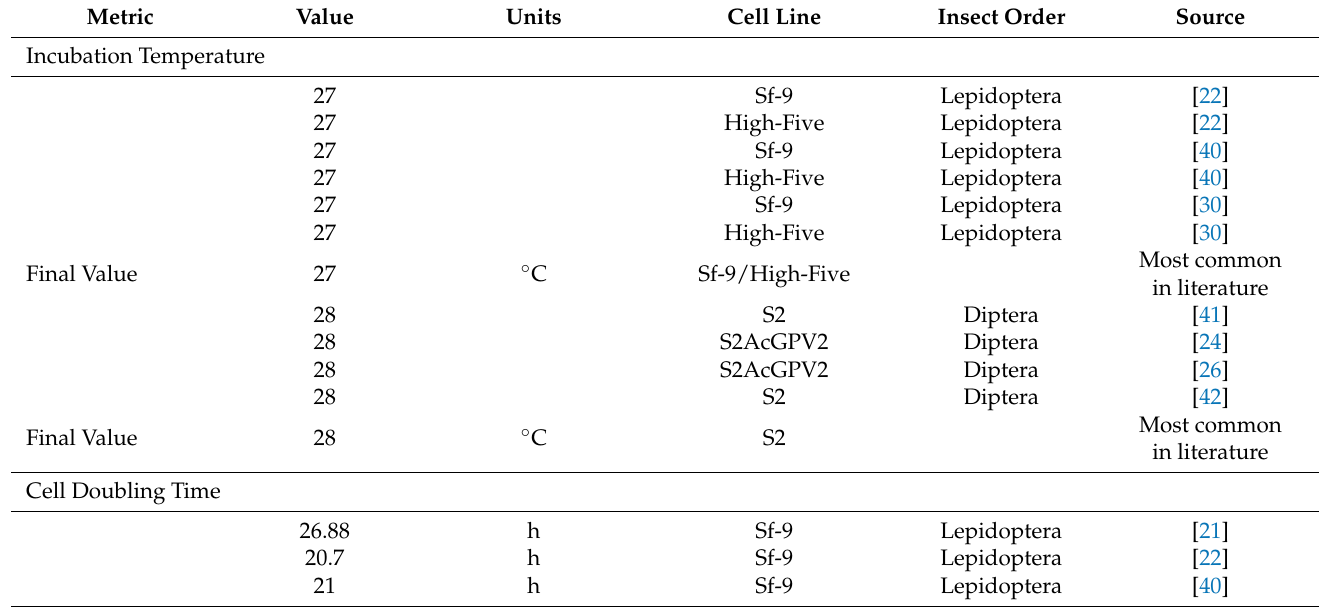
Table A1. Parameters changed for insect cell model. Values used for each scenario listed with